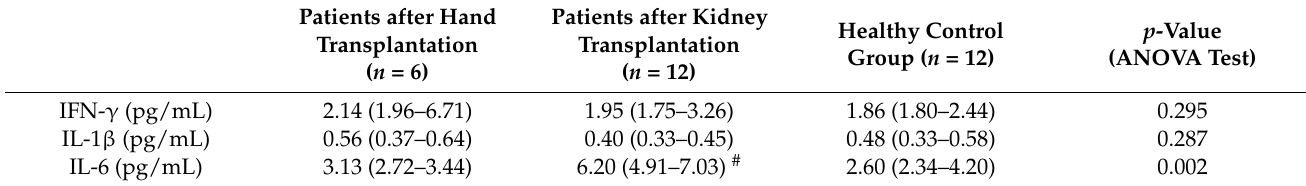
Table 4. Pro-inflammatory cytokines levels in